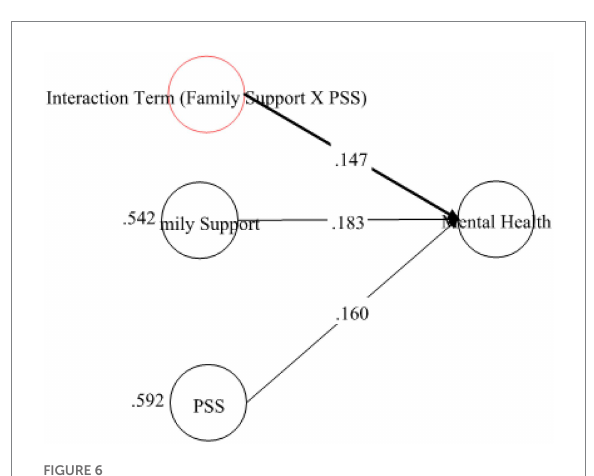
FIGURE 6 Theoretical model for mediation of coping strategy between FS and